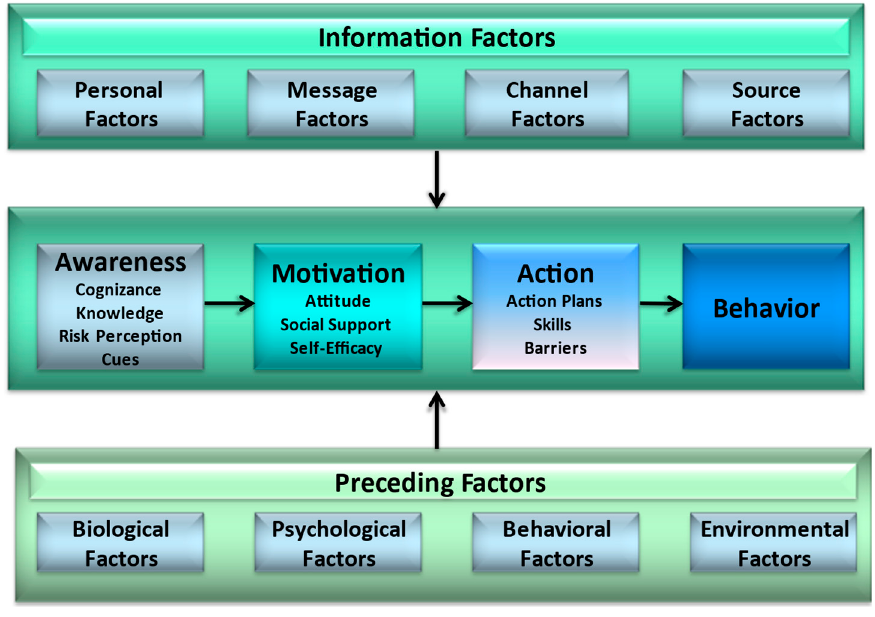
Figure 1. The I-Change Model [18].